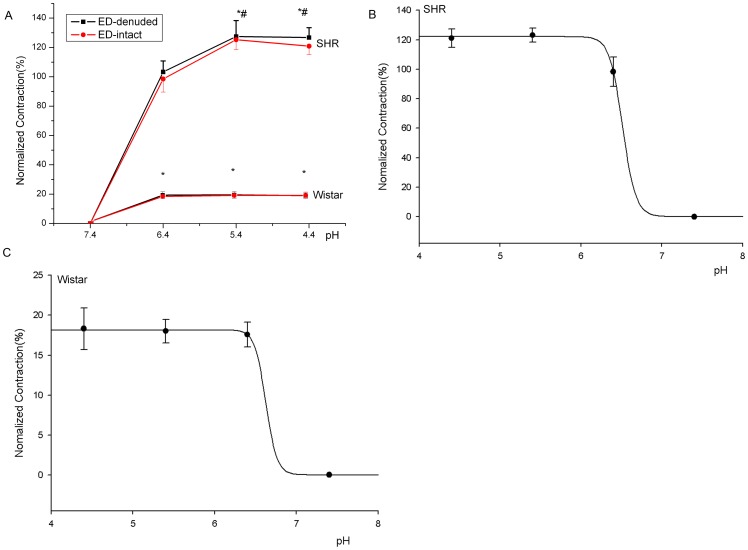
Effect of extreme and severe acidosis on thoracic aorta contraction for SHRs (n = 6) and Wistar rats (n = 6).A, Extreme and severe acidosis induced contraction of both ED-intact and ED-denuded thoracic aorta rings. B, C, pH-response fitting curves of the EC50 for SHRs and Wistar rat aorta rings (6.51 vs 7.11, P<0.05). *P<0.01, compared with the contraction at pH 7.4. #
P<0.05, compared with the contraction at pH 6.4.